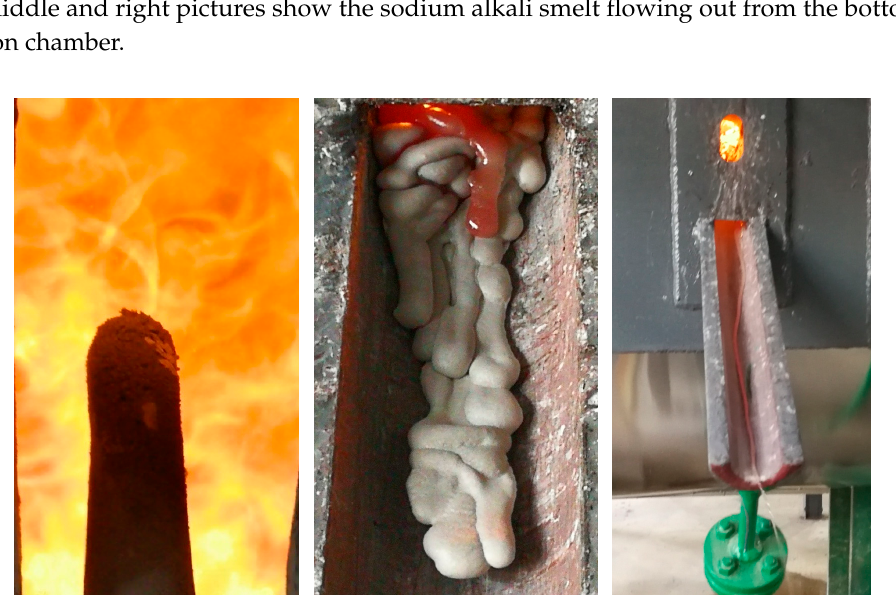
Figure 8. Furnace flame and smelt outflow.